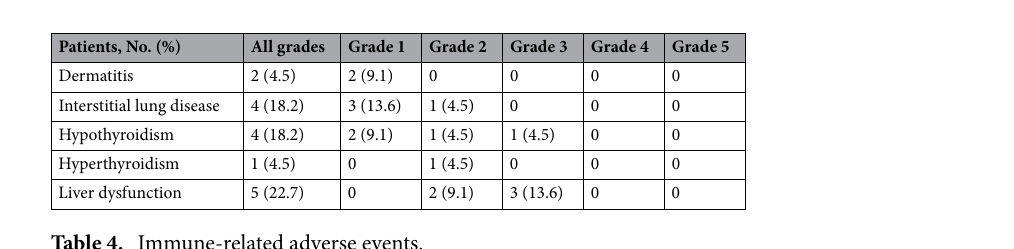
Table 4. Immune-related adverse